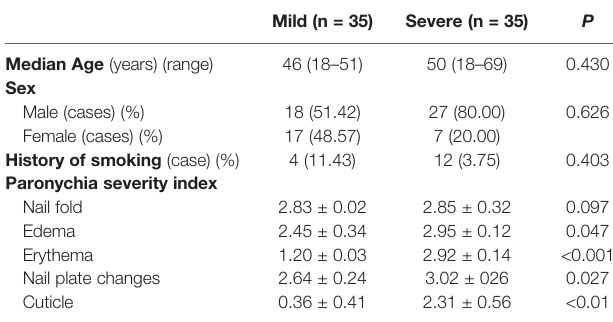
TABLE 1 | Clinical characteristics of patients with